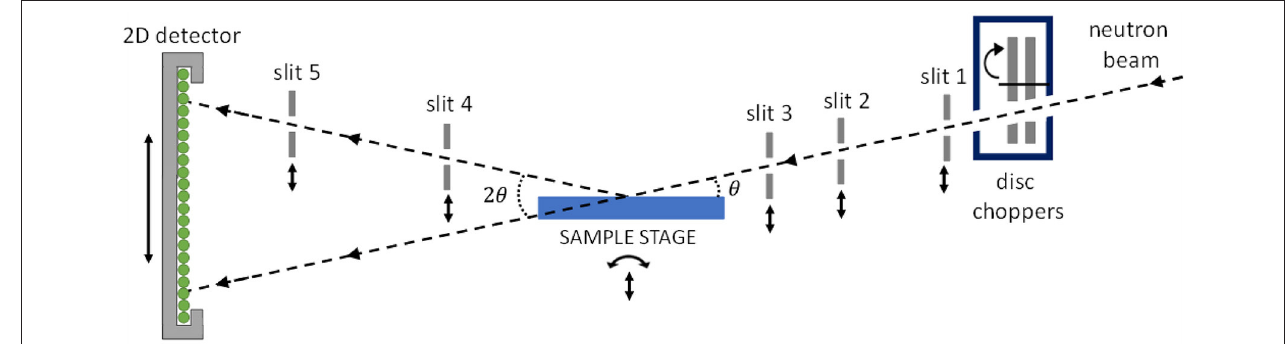
FIGURE 1 | Schematic of the energy-dispersive reflectometer (AMOR) operating at SINQ, PSI.